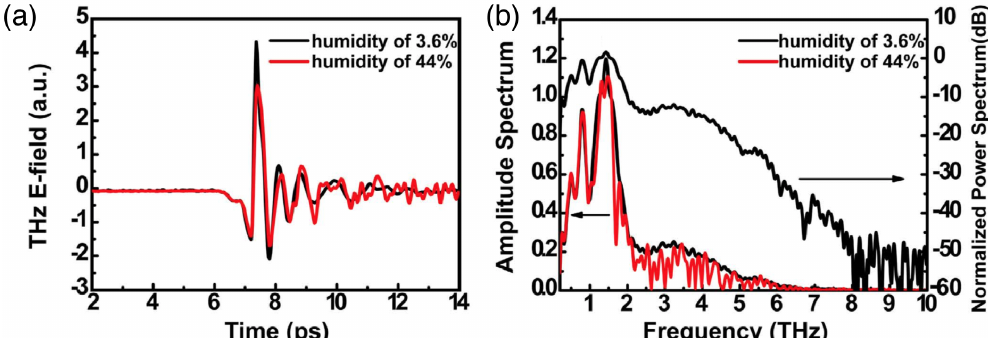
Figure 12. ( a ) THz time-domain signal and ( b ) the corresponding amplitude and power spectrum achieved in a compact terahertz setup based on DSTMS (0.3 mm thick) as THz generator and photoconductive antenna as THz detector and a pump laser with pulse length of <100 fs, >200 mW average power, 80 MHz repetition rate and 1560 nm central wavelength [79]. The red lines represent signals measured in air with a humidity of 44% and black lines are those obtained in dry-air environment. Reprinted from Ref. [79]. Licensed by Creative Commons CC BY